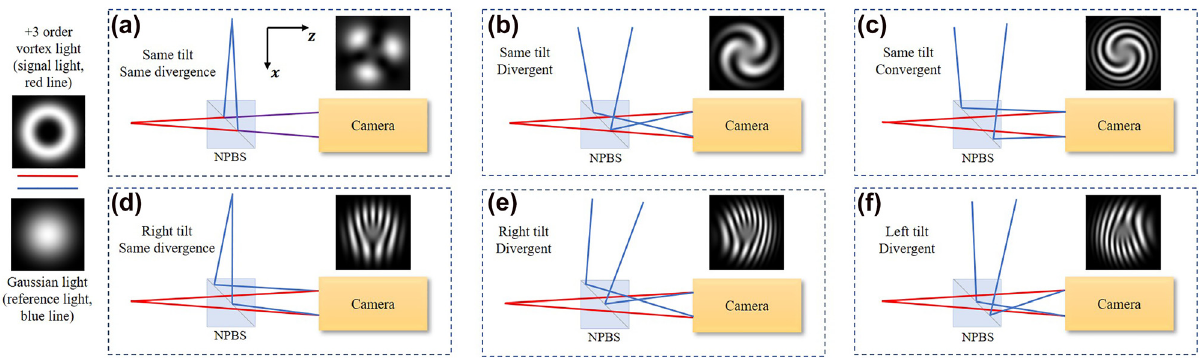
Figure 2: Diagramof the process thata purethird azimuthalorder vortexlight (red line)interferes with Gaussianlights (blue line) possessing (a) the same tilt and the same divergence (b) the same tilt and divergent (c) same tilt and convergent (d) right tilt and the same divergence (e) right tilt and divergent (f) right tilt and convergent relative to the signal vortex light. NPBS, nonpolarized beam